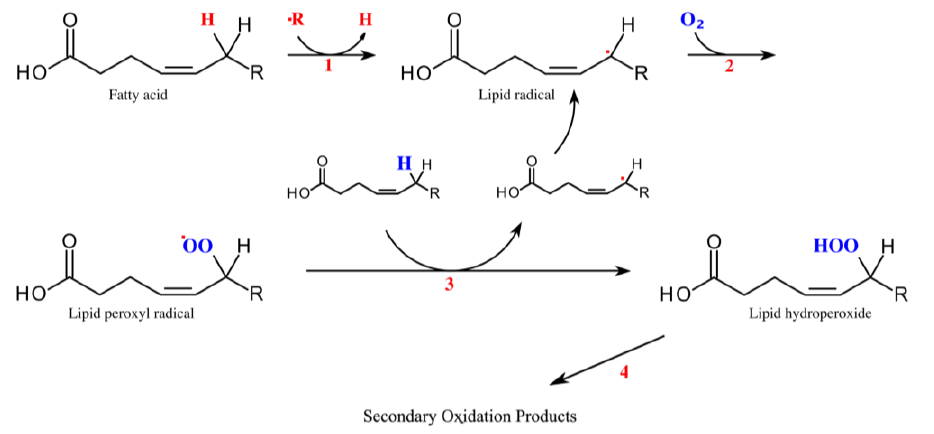
Figure 1. Lipid peroxidation. Modified from [12]. Two steps are essential for lipid peroxidation — initiation (1) and propagation (2). During initiation, a hydrogen atom is removed from the fatty acid forming a lipid radical (1). This can happen through enzymatic reactions from lipoxygenases, hydroperoxide-lyases and peroxygenases or by non-enzymatic processes. During propagation, the lipid radical reacts with oxygen which produces a peroxyl radical (2). In the next step the peroxyl radical reacts with another unsaturated lipid. It abstracts a hydrogen atom to form a hydroperoxide radical and a new lipid radical (3). Hydroperoxide radicals are unstable and quickly react to form other radicals and secondary products. In further cyclization reactions and cleavages, different compounds are produced including straight-chain aliphatic aldehydes (4) [8].